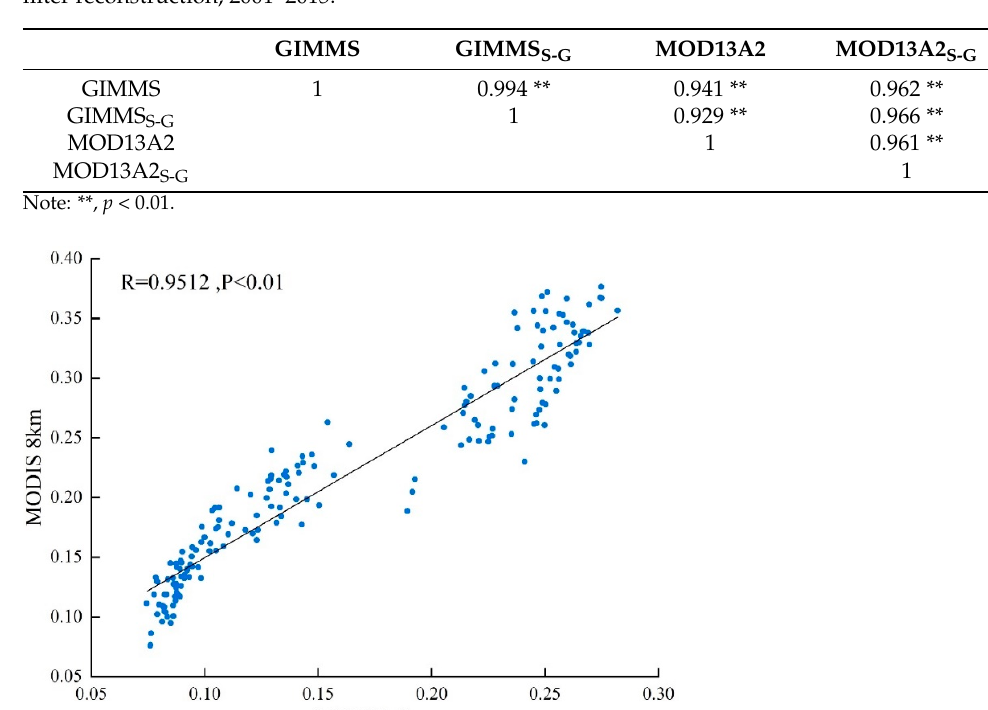
Table 1. Precision validation of GIMMS NDVI3g and MOD13A2 NDVI data before and after S–G filter reconstruction, 2001–2015.